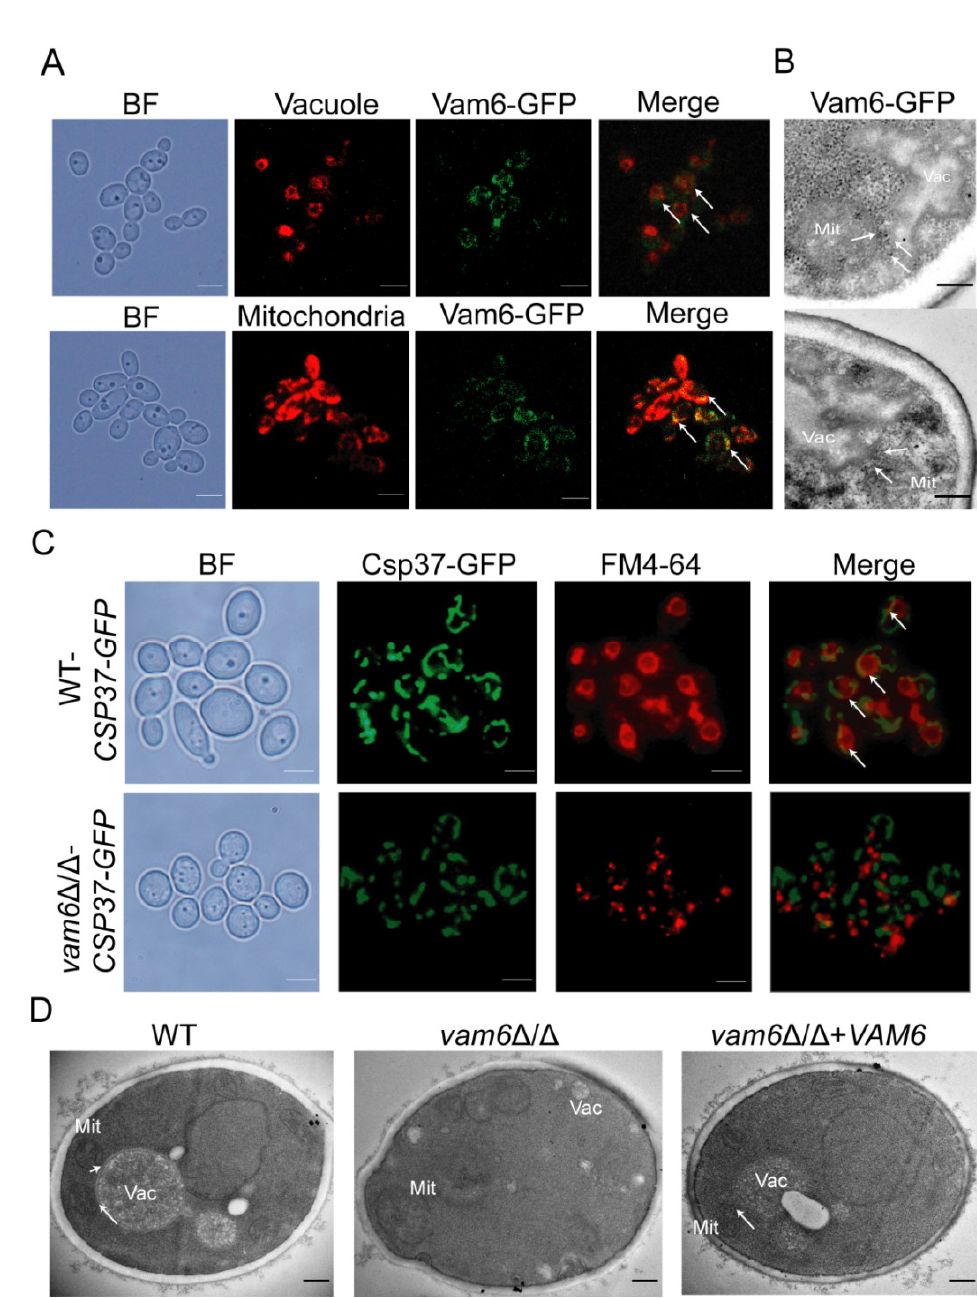
Figure 1. Intracellular localization of Vam6 and its role in formation of vCLAMPs. ( A ) Localization of Vam6 in C. albicans . Bar = 5 μm. ( B ) The localization of Vam6-GFP was observed by immuno trans- mission electron microscope. The Vam6-GFP was visualized using Anti-GFP IgG/Rabbit and Goat Anti-Rabbit IgG/Gold (10 nm). Mit, mitochondria; Vac, vauoles. Bar = 200 nm. ( C ) Colocalization of the mitochondria and the vacuoles in WT and vam6 ∆ / ∆ . The white arrows indicate vCLAMPs. Bar = 5 µ m. ( D ) TEM images of the cells under oxidative stress. The cells were cultured in liquid YPD containing 5 mM H 2 O 2 for 1 h, fixed and cut for TEM observation. Bar = 200